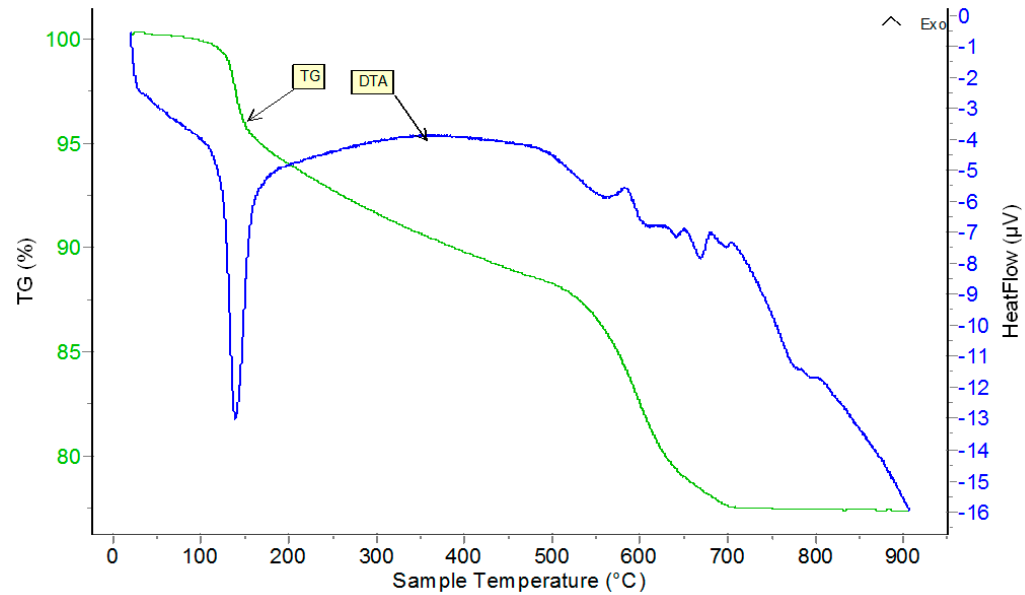
Figure 9. Thermal dehydration of tincal with thermal analysis with TG (green) and DTA (blue) curves regarding standard tincal.